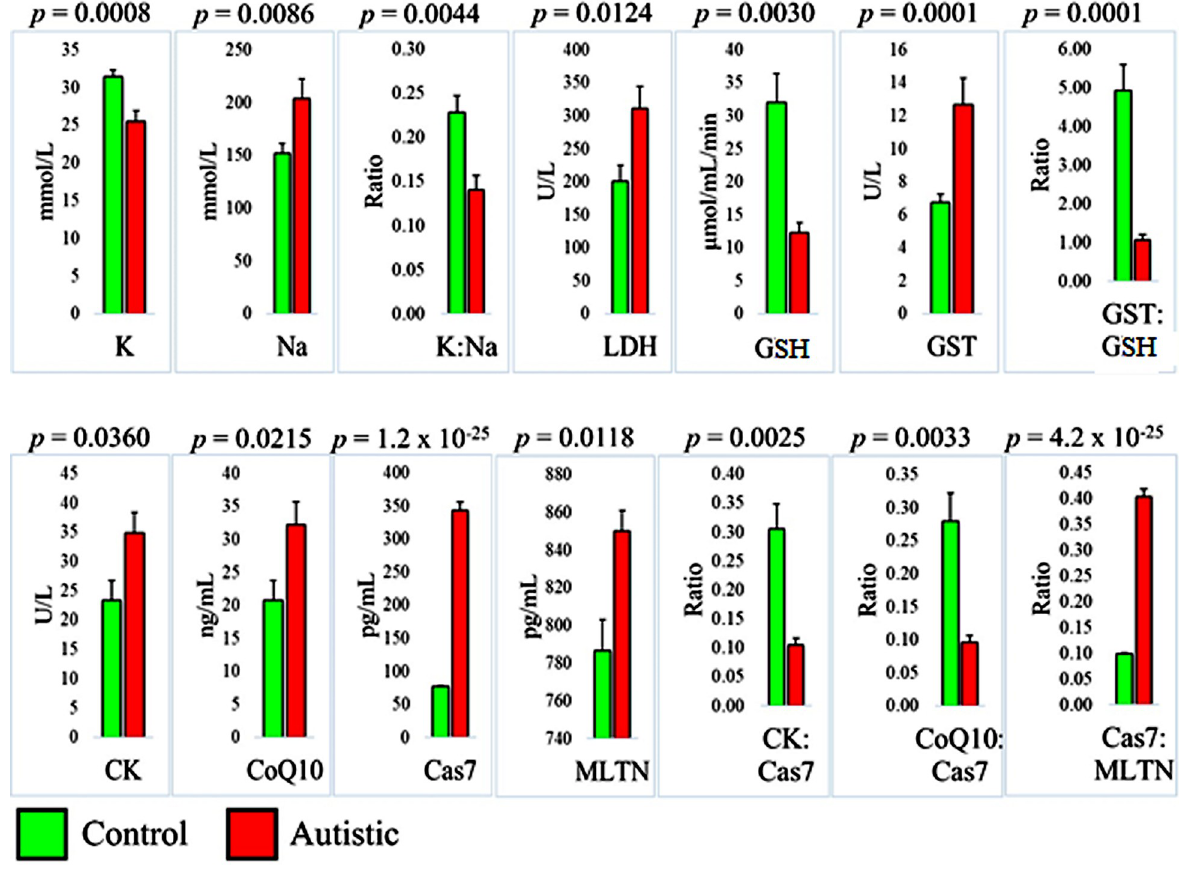
Fig 1. Differences between autistic individuals (n = 13) and aged-matched healthy controls (n = 24) with regard to 9 biomarkers and 5 biomarker ratios. K: potassium, Na: sodium, LDH: lactate dehydrogenase, GSH: glutathione, GST: glutathione S-transferase, CK: creatine kinase, CoQ10: co-enzyme Q10, Cas7: caspase 7, and MLTN: melatonin. Statistical significance was determined using a two-tailed student’s t-test.